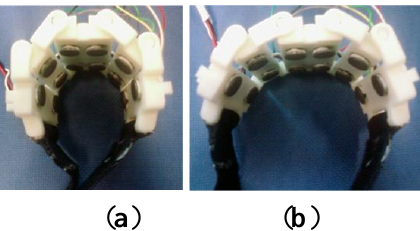
Figure 2. ( a ) Multi-channel sEMG sensor ring for slim forearms. ( b ) Multi-channel sEMG sensor ring for robust